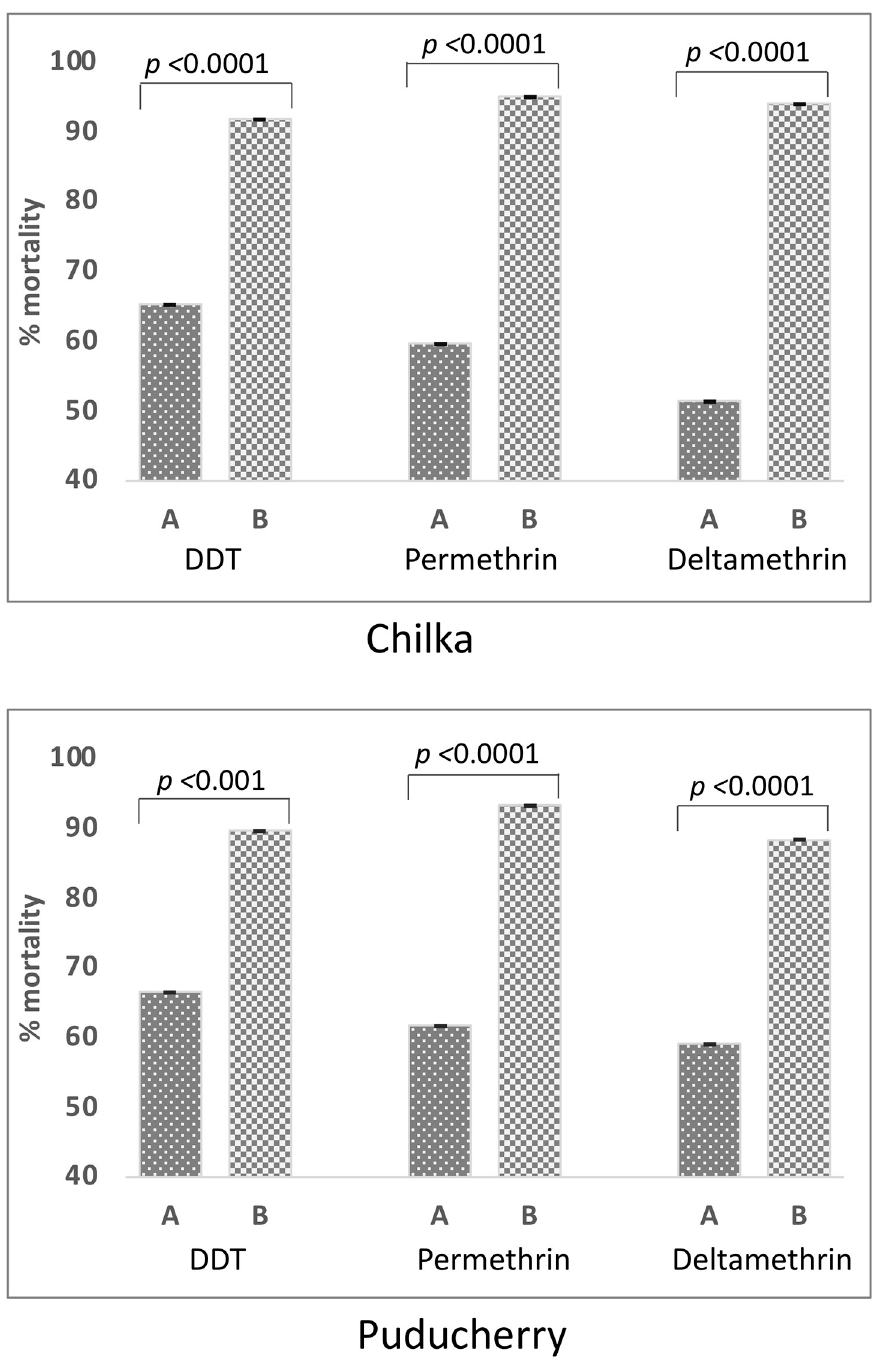
Fig 4. Bar chart showing relative corrected percent mortalities of two molecular forms of An . subpictus in two sympatric populations following standard WHO insecticide susceptibility tests against diagnostic doses of the insecticides. The p -value of the test of significance (chi-squared) between percent mortalities in Form A and B is shown on the top of bars.